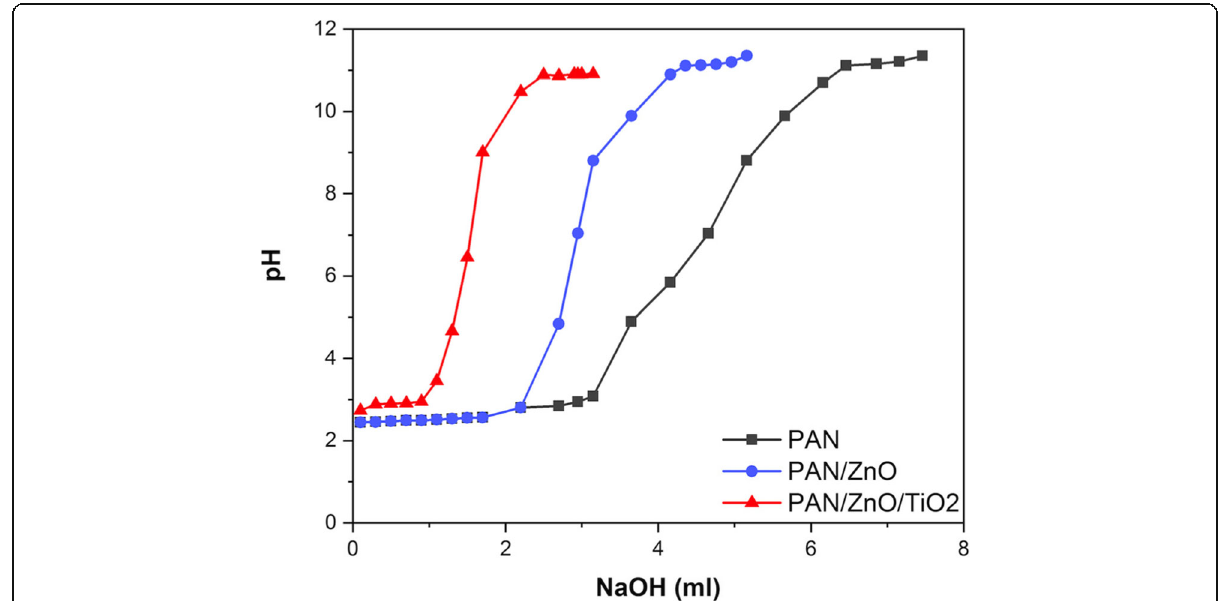
Fig. 7 pHpzc of a PAN n -fib@Mat, PAN/ZnO n -fib@Mat, and PAN/ZnO-TiO 2 n-